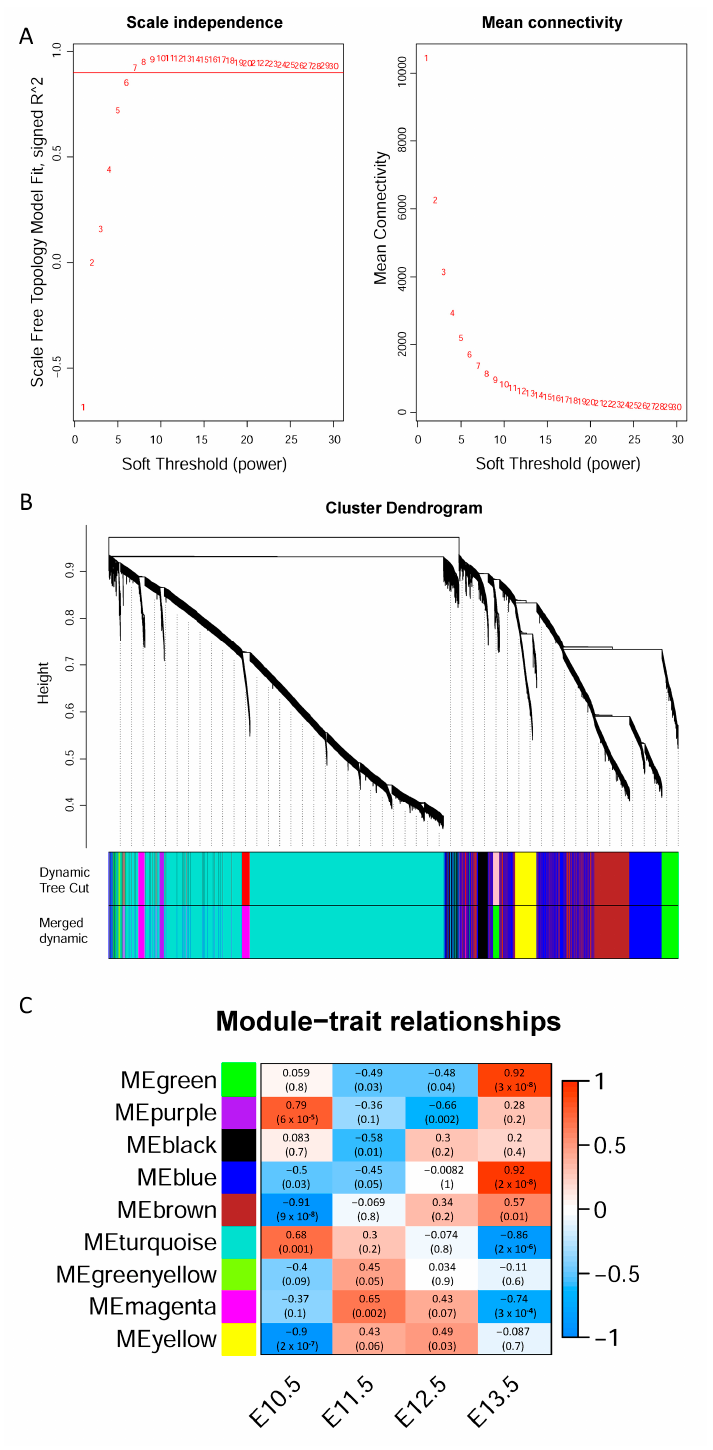
Figure 2. Weighted gene co-expression network analysis of hindlimb transcriptome. ( A ) Scale-free topology fit index R 2 as a function of the soft thresholding power ( β ) plot (left). Mean connectivity as a function of the soft thresholding power ( β ) plot (right). ( B ) Network dendrogram of WGCNA by hierarchical clustering with dynamic tree cut and merged dynamic modules. Modules were divided according to height with dynamic tree-cut algorithm in the upper panel, and modules were merged according to their similar expression patterns with the merged dynamic algorithm in the lower panel. ( C ) Association of nine modules and four developmental stages. In each box, the upper value represents the association coefficient, and the lower value represents the